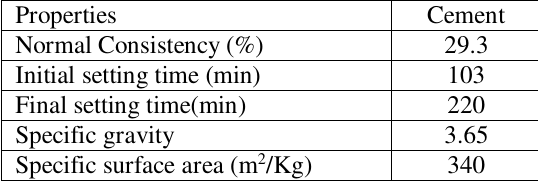
Table 2: Physical properties of ordinary